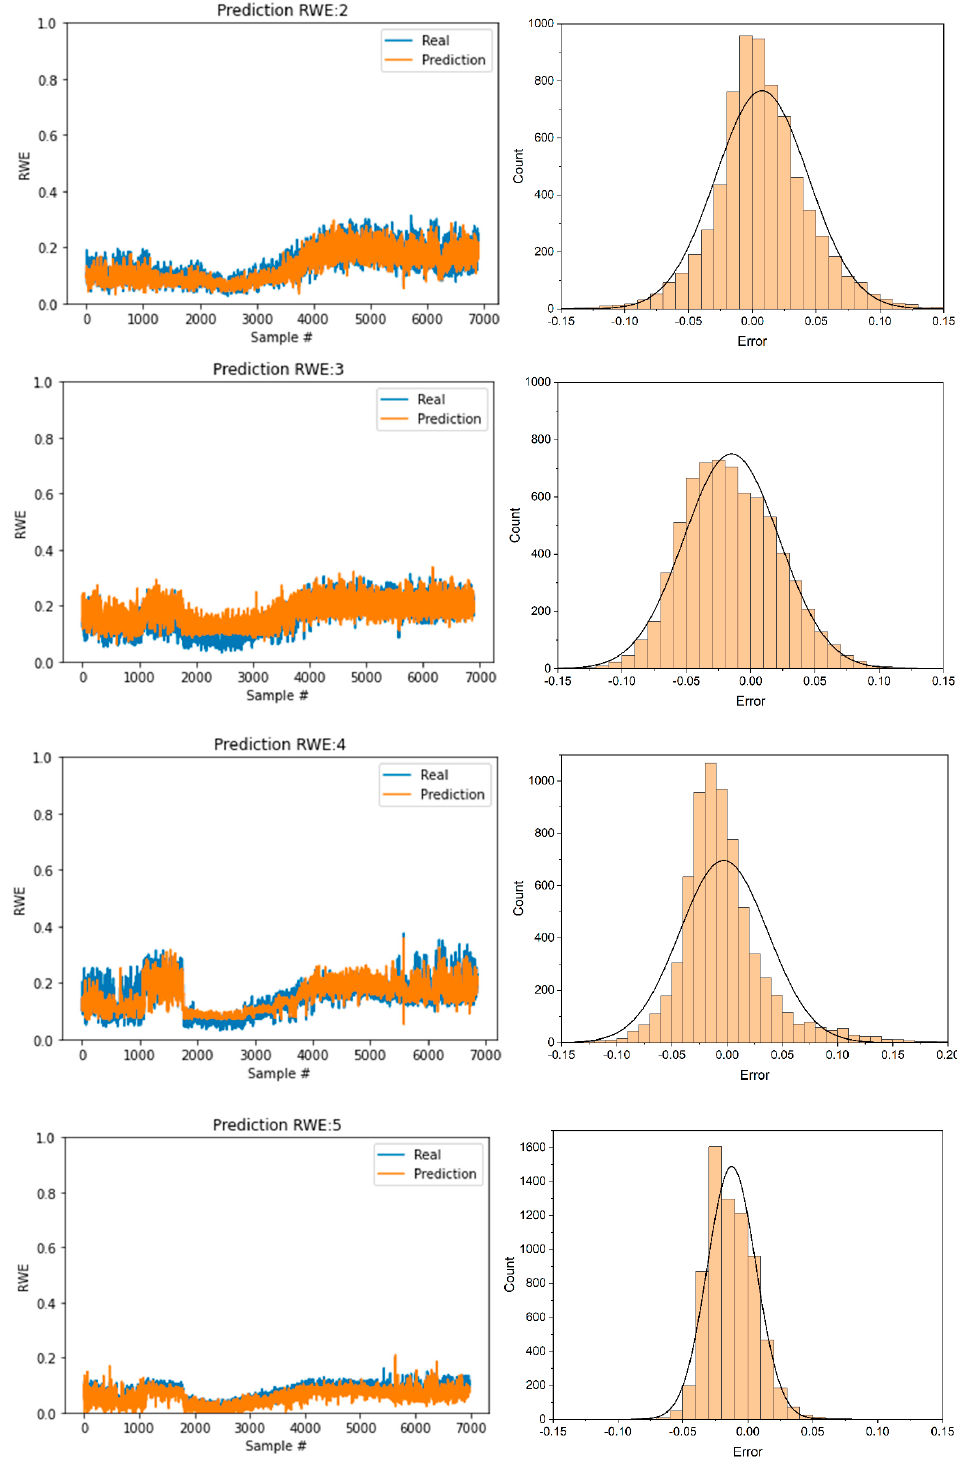
Figure 9. Results of the RWE–LSTM model prediction with five levels of the RWE ( left ) and his- tograms of the prediction errors with normal distribution analysis ( right